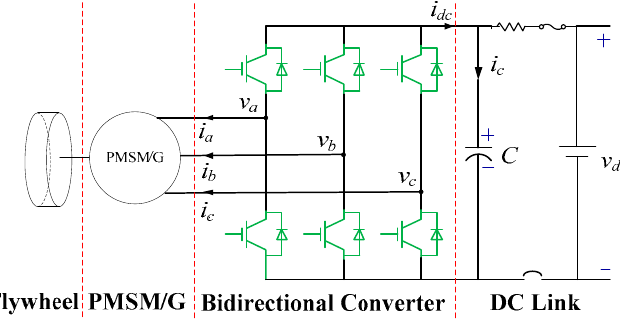
Figure 1. Schematic of the FESS.